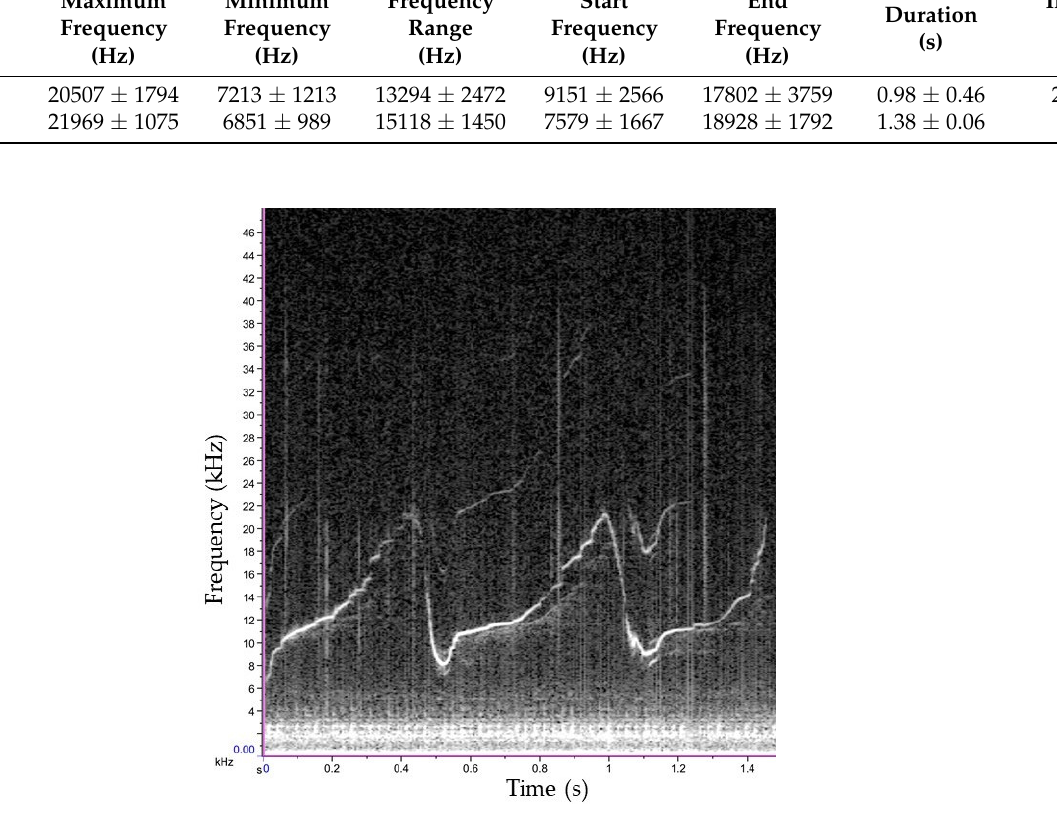
Figure 6. Signature Whistle (SW_01) identified in the recordings from the first encounter (Hamming window, size 2048, DFT 2048, Overlap 50 %, Hop size 1024).